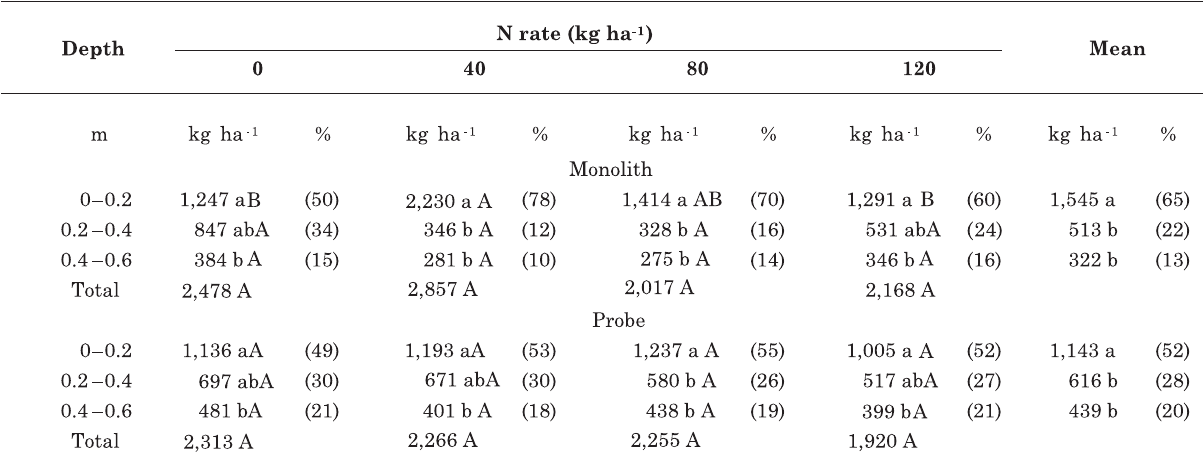
Table 3. Distribution of the sugar cane root system in the soil profile, in terms of depth and nitrogen fertilization at planting by two evaluation